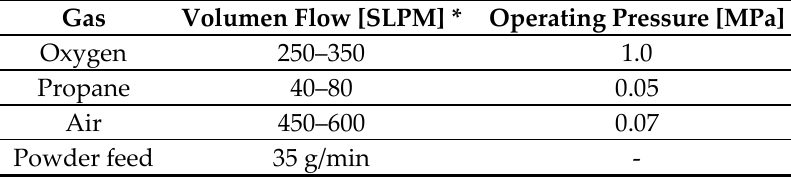
Table 2. Feature of the characteristics of experimental HVOF samples